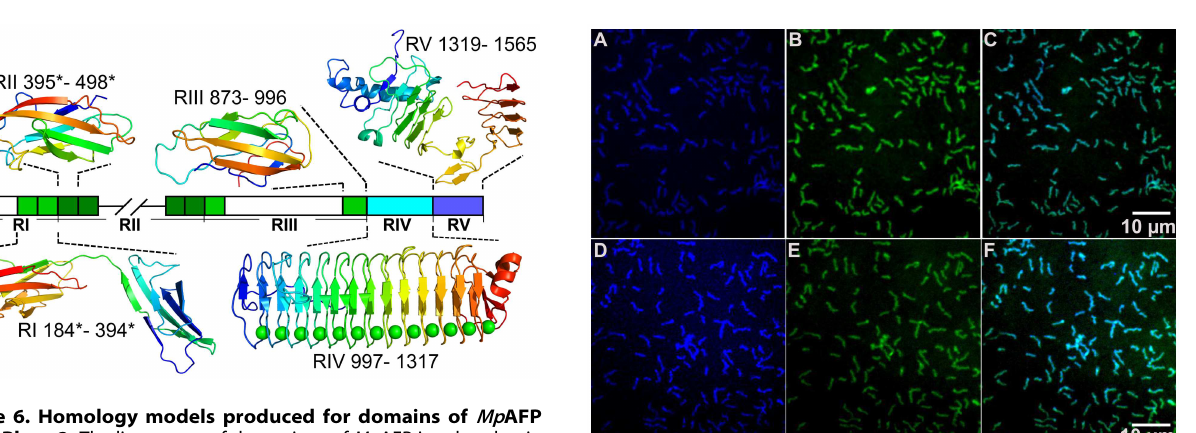
Table 1. Statistics of homology modeling studies on Mp AFP domains.